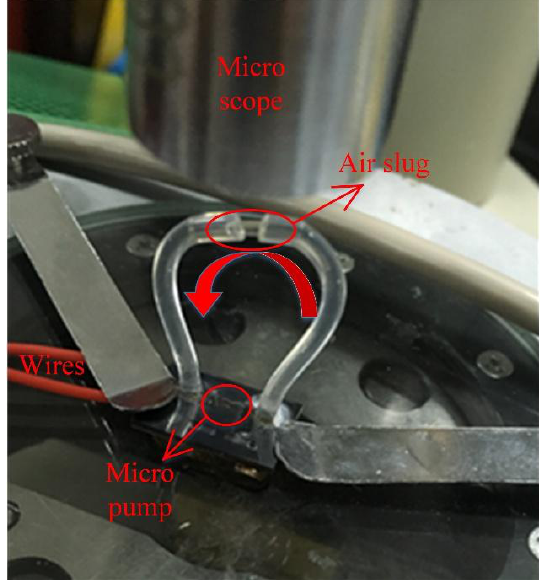
Figure 6. Measurement of the flow rate.